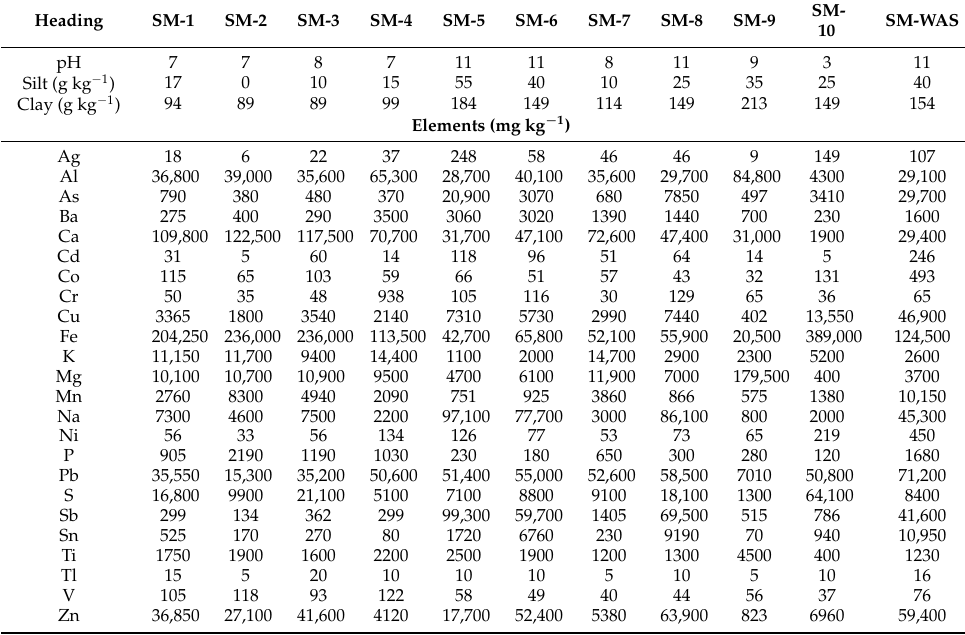
Table 1. Main physicochemical characteristics of the facility waste and slag obtained from the La Cruz